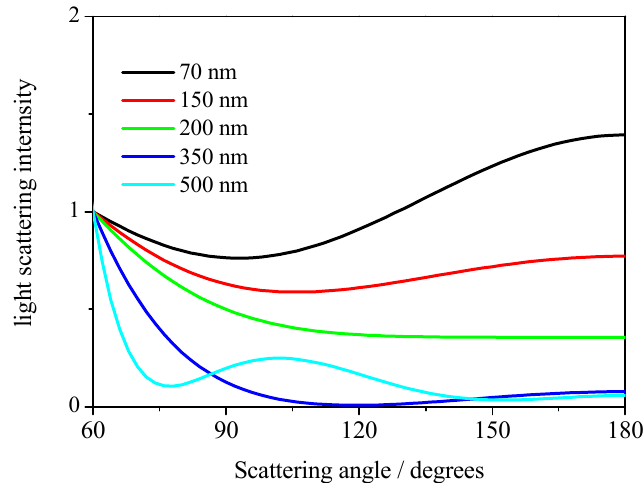
Figure 1. Light scattering intensity as a function of the scattering angle for different sizes of particle (70, 150, 200, 350, and 500 nm). The light scattering intensities are normalized by their theoretical values at a scattering angle of 60°. In this calculation, the refractive index of polystyrene latex particles was taken to be 1.59 and that of water was assumed to be 1.33.